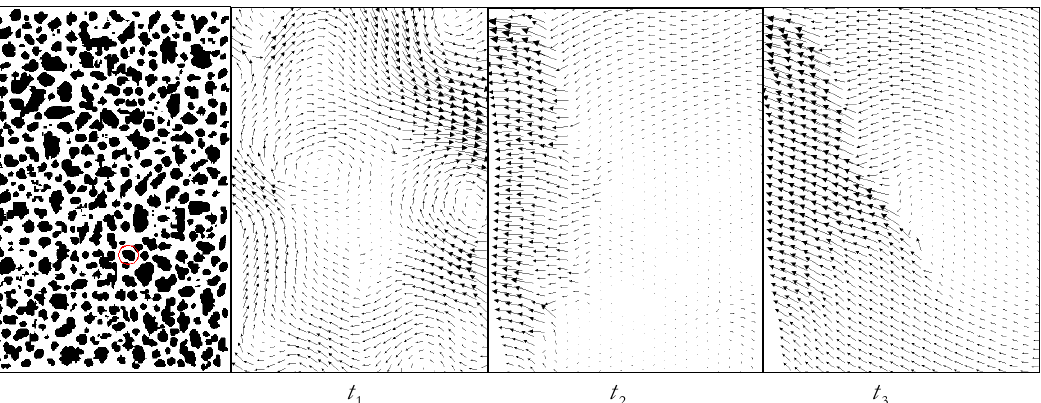
Figure 9: Simulation shift-fields for the composite with 40% content of the hardening particles in the case of ideal sliding on the loading